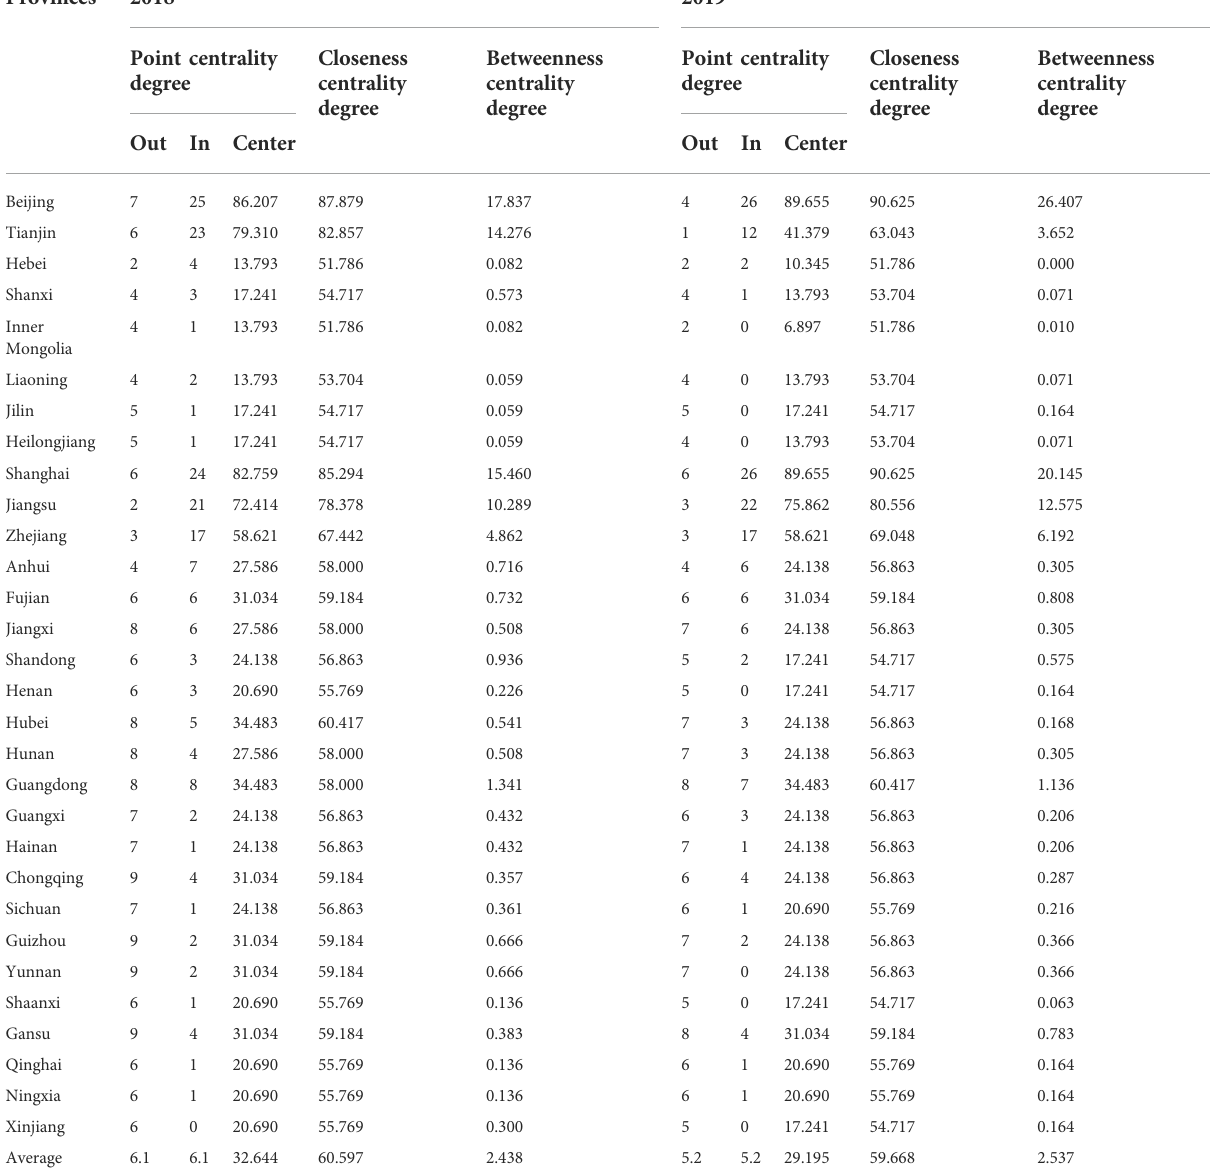
TABLE 5 Network centrality analysis of spatial correlation of regional green ef fi ciency in